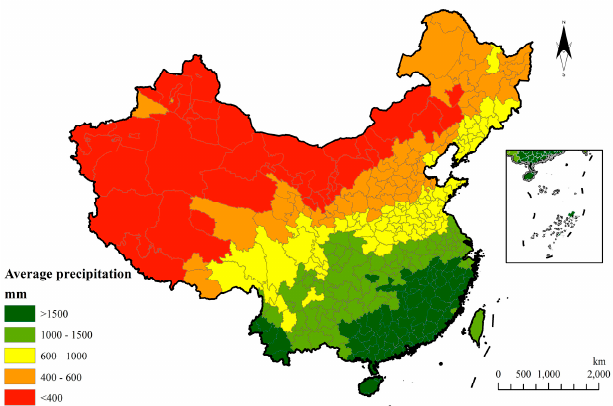
Figure 5. Distribution of average annual precipitation in 60 years.